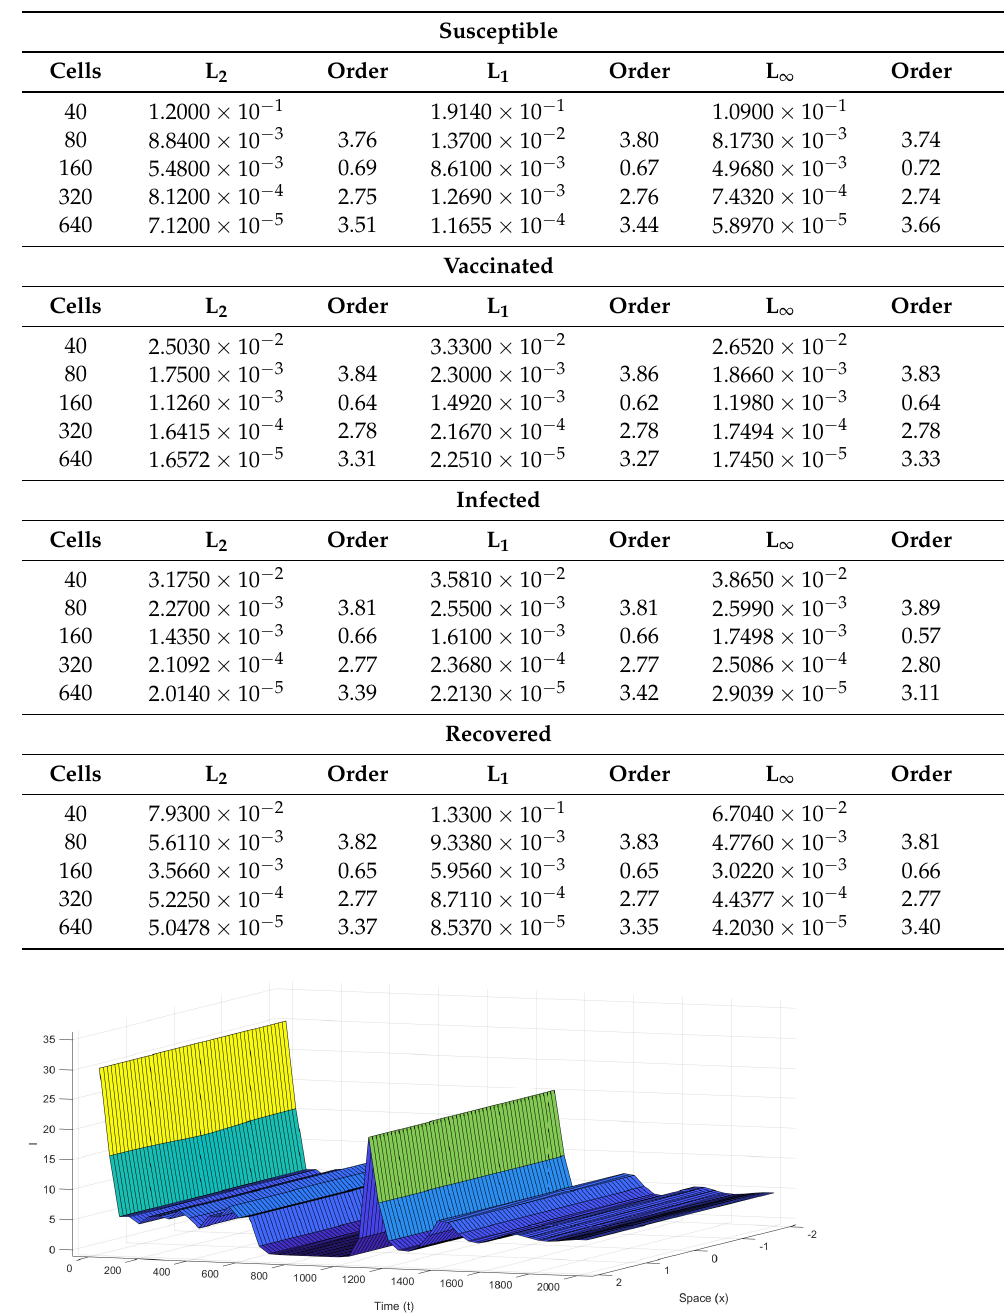
Table 2. SVIR with Diffusion Manufactured Solutions for Fortran code Error Norms and correspond- ing Order, for t = 0.25.